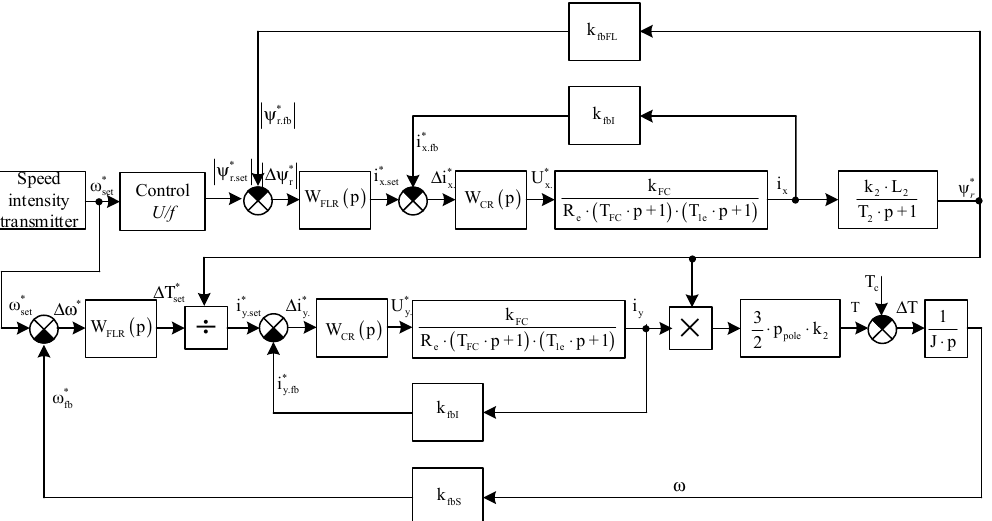
Figure 1. Structural scheme of the vector control system (* values presented in relative units of meas- urement).